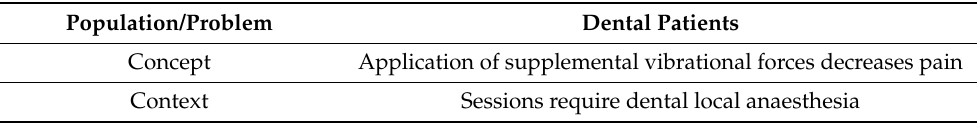
Table 1. Research question based on the PCC (Population/Problem, Concept, Context)